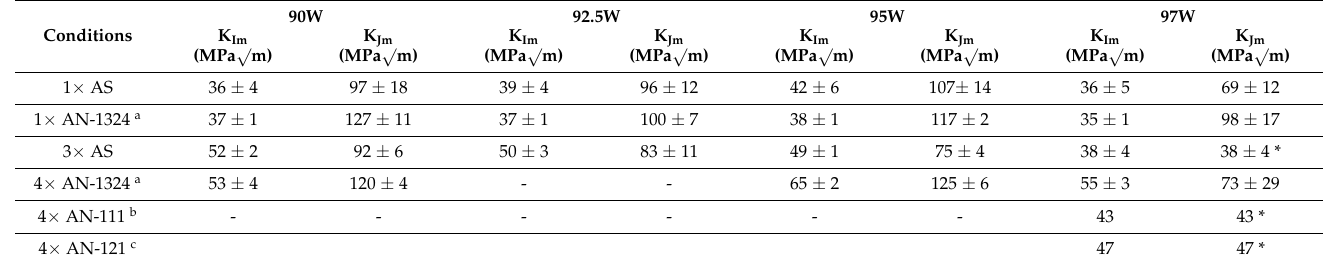
√ m) of AS [14,27] and AN WHAs.